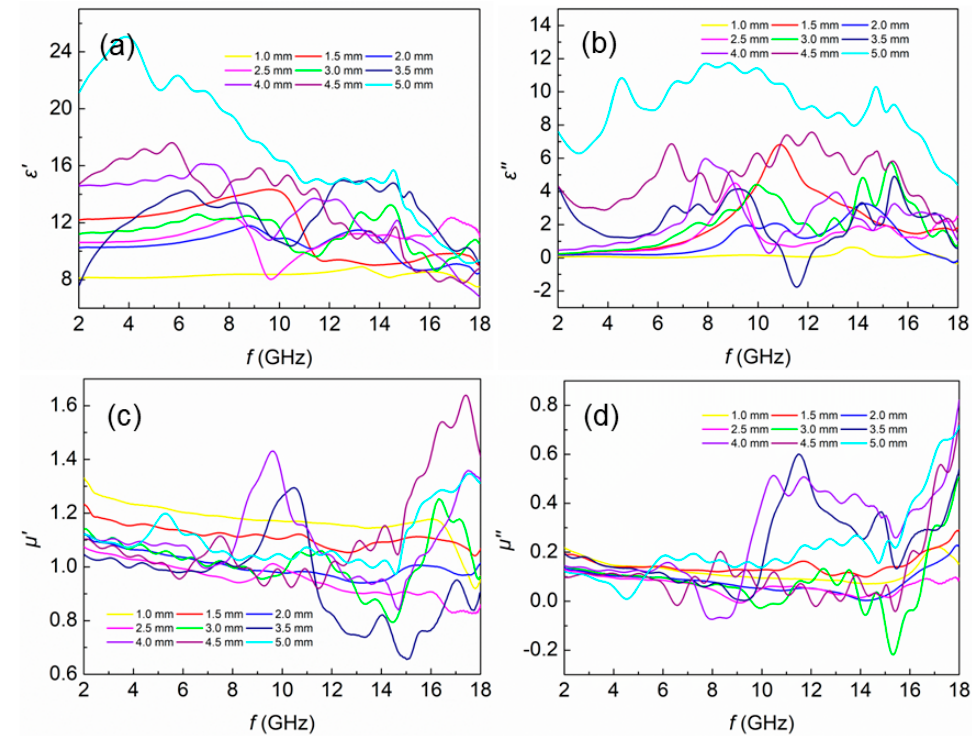
Figure 1. Frequency dependence of electromagnetic parameters of as-prepared FeSiBNi2 metallic microwires mass ratio of 30 wt.%, with different thickness of the composite at 2–18 GHz: ( a ) ε ′ ; ( b ) ε ′′ ; ( c ) μ ′ ; ( d ) μ ′′ .